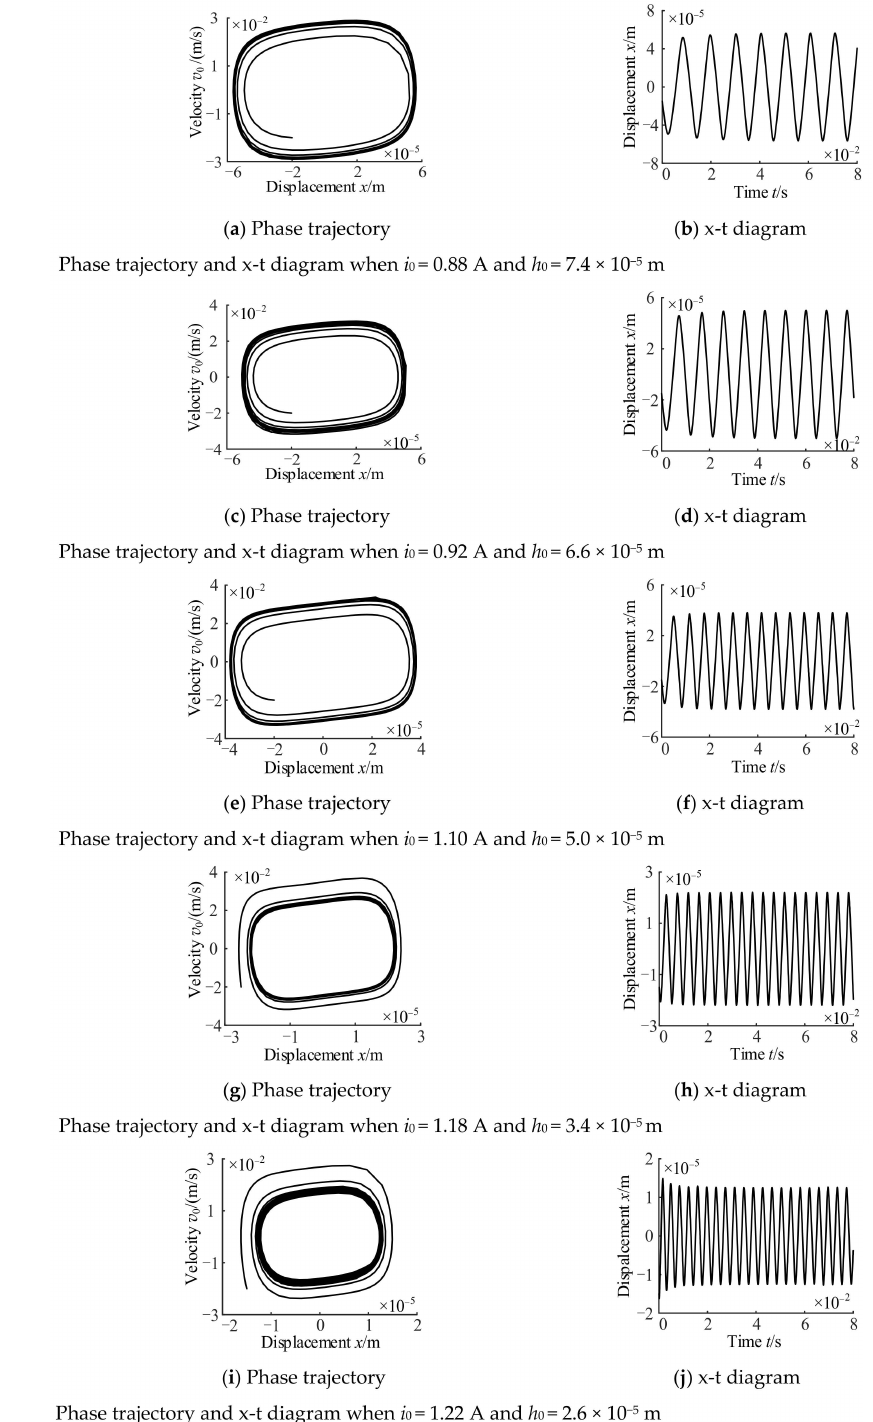
Figure 10. Phase trajectory and x-t